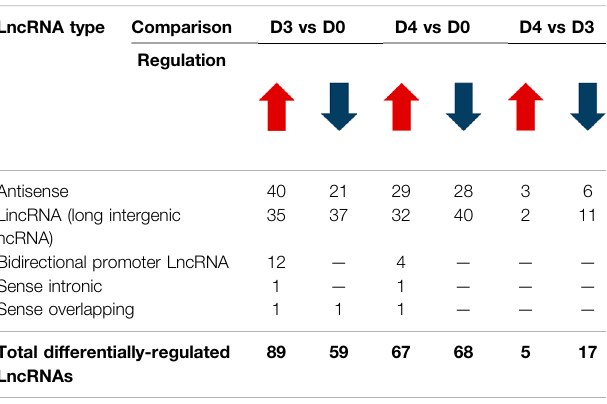
TABLE 1 | Differentially-regulated Long non-coding RNAs (LncRNAs) during osteoclast